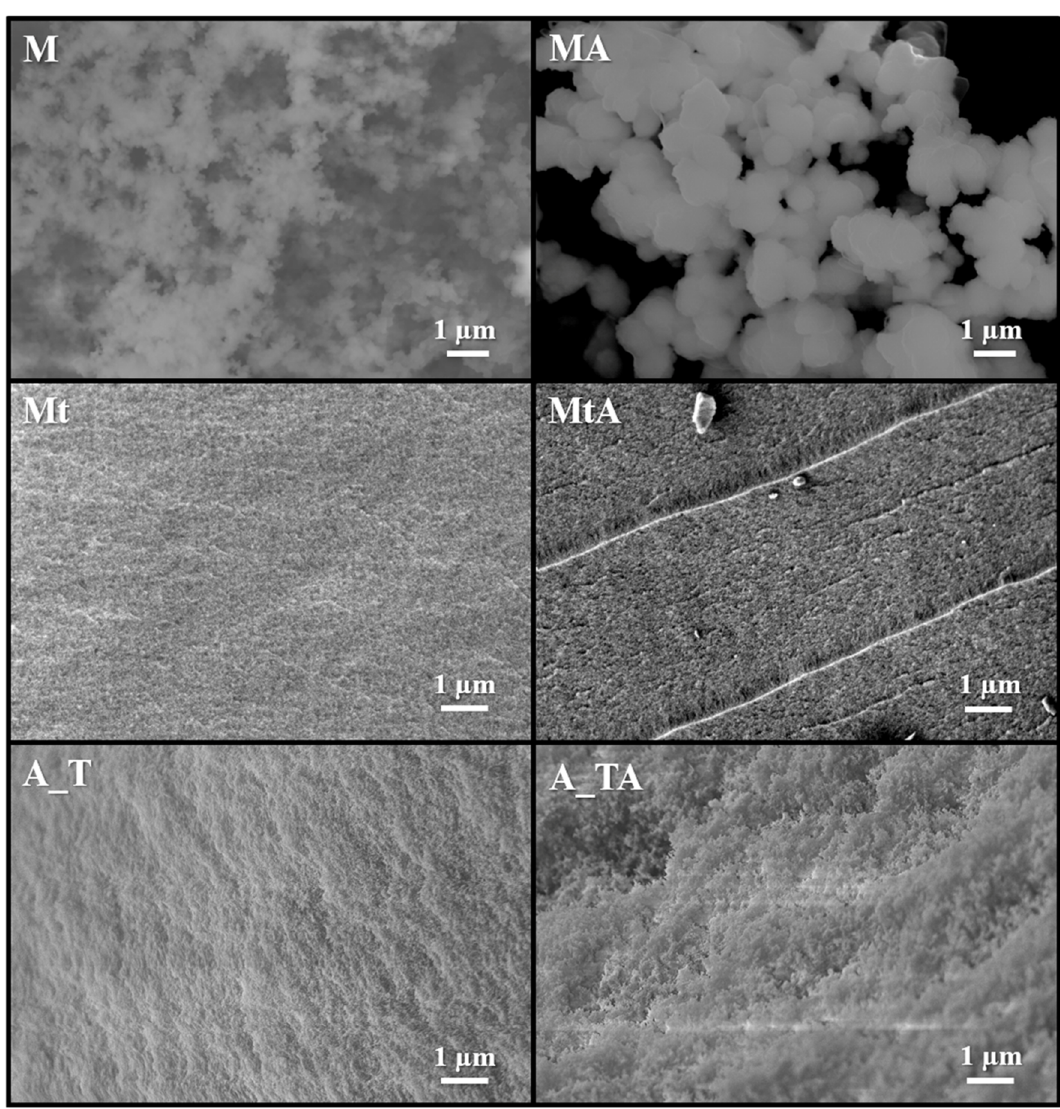
Figure 1. SEM images of the adsorbents M and MA (Reprinted with permission from Reference [54] Copyright (2019) Elsevier), and Mt, MtA, A_T and A_TA.